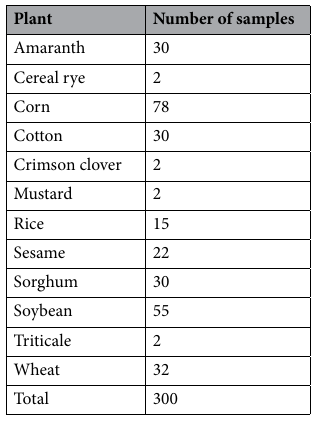
Table 2. Plant species used in this